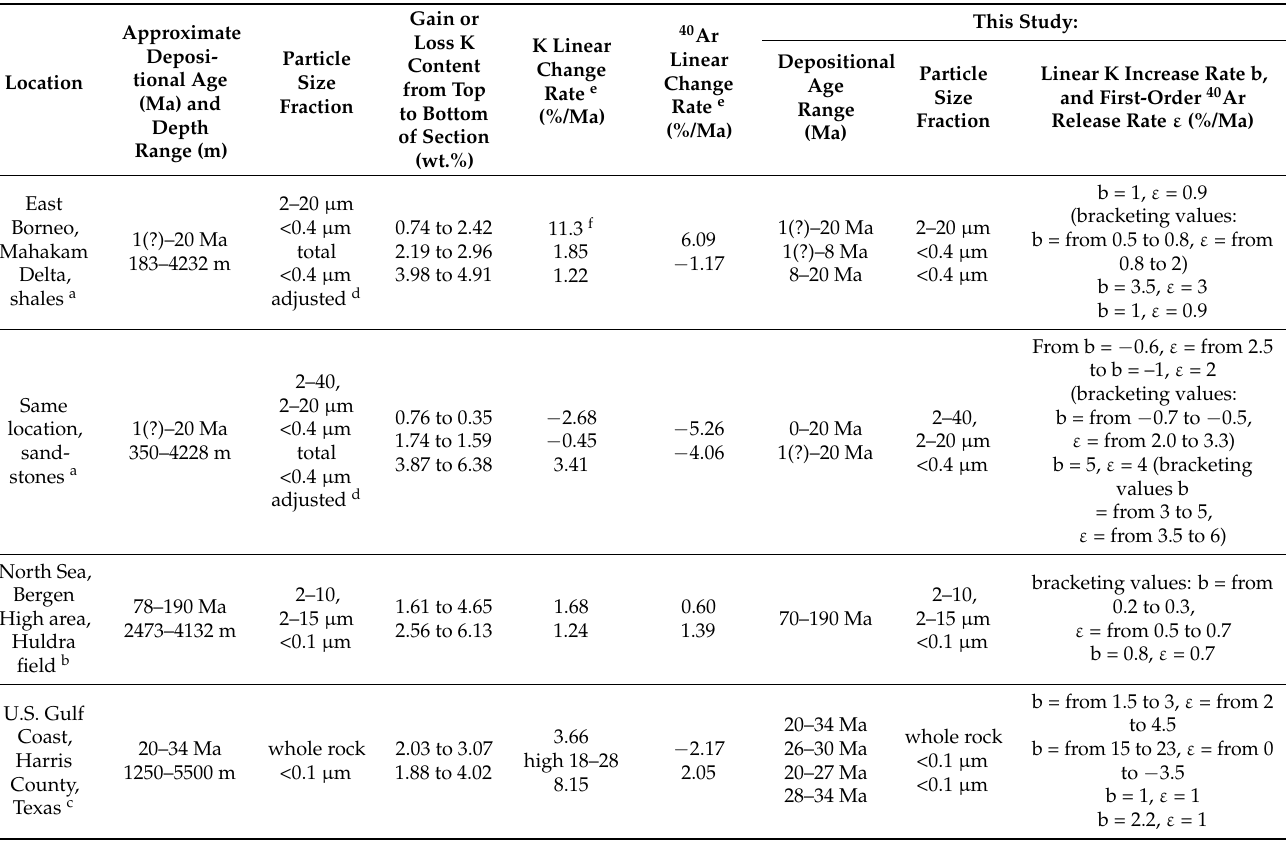
Table 1. Summary of stratigraphic data, particle size fractions, K and 40 Ar concentration changes for the depositional age intervals as given in the references cited, and the model linear K addition rates (b) and first-order 40 Ar release rates ( ε